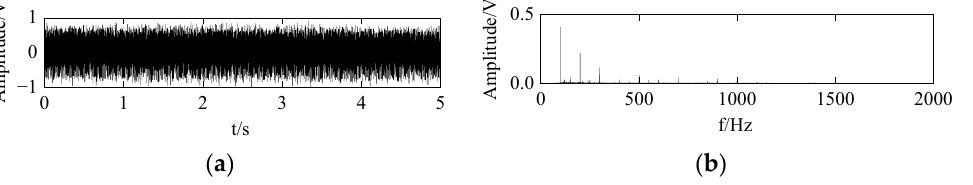
Figure 12. Waveform and spectrum of the reference signal in the substation; (( a ): waveform; ( b ): spectrum.).